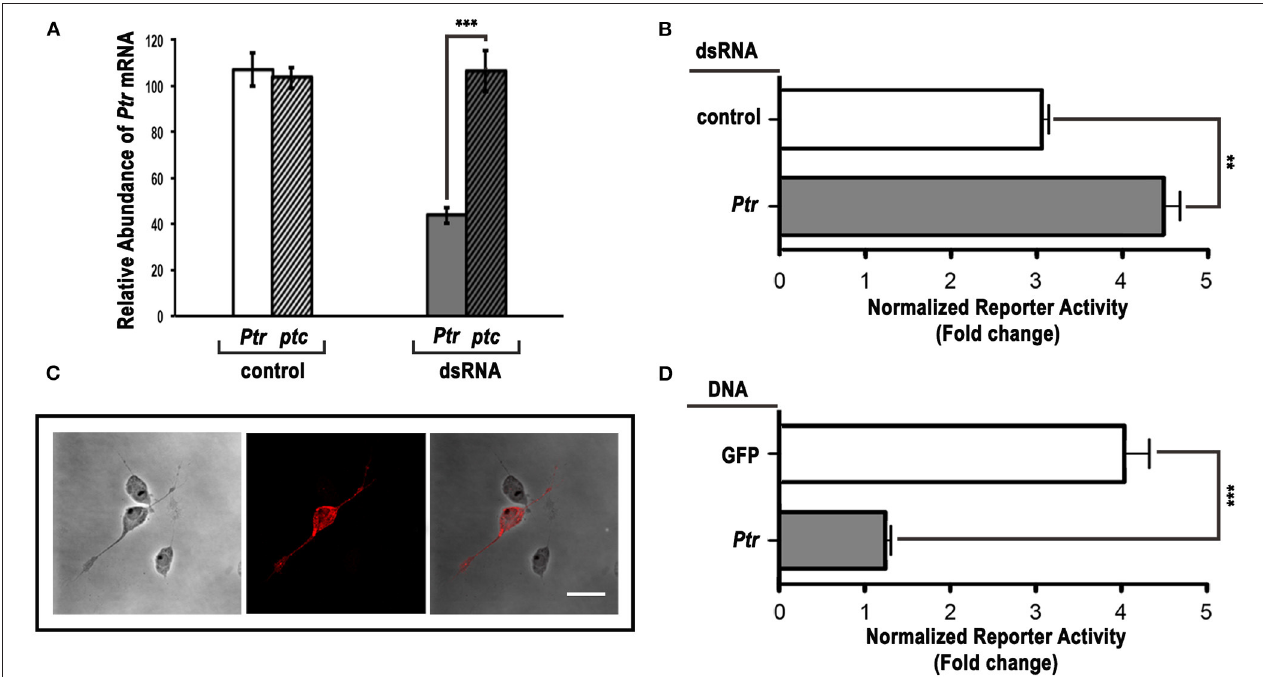
FIGURE 4 | Ptr can act as a negative regulator of the Hh pathway in cl-8 cells. (A) The Ptr -specific dsRNA efficiently reduced the level of Ptr transcripts. Downregulation was specific for the target Ptr gene, and no changes were detected in the ptc expression level. (B) dsRNA targeting Ptr moderately enhanced the responsiveness to Hh when compared to the control dsRNA. (C) The Ptr-V5 overexpression in cl-8 cells was verified by immunostaining using a specific anti-V5 antibody (red). (D) Ptr expression strongly reduced the response to the Hh signal. As a control, a construct expressing GFP was transfected into cl-8 cells. In (B,D) , white bars are controls and gray bars are the experimental condition, respectively. Data are presented as mean ± SEM ( n = 3 per group). Analysis was performed using the unpaired two-tailed Student’s t -test, ** p < 0.01 and *** p < 0.001. Bar: 5 µ